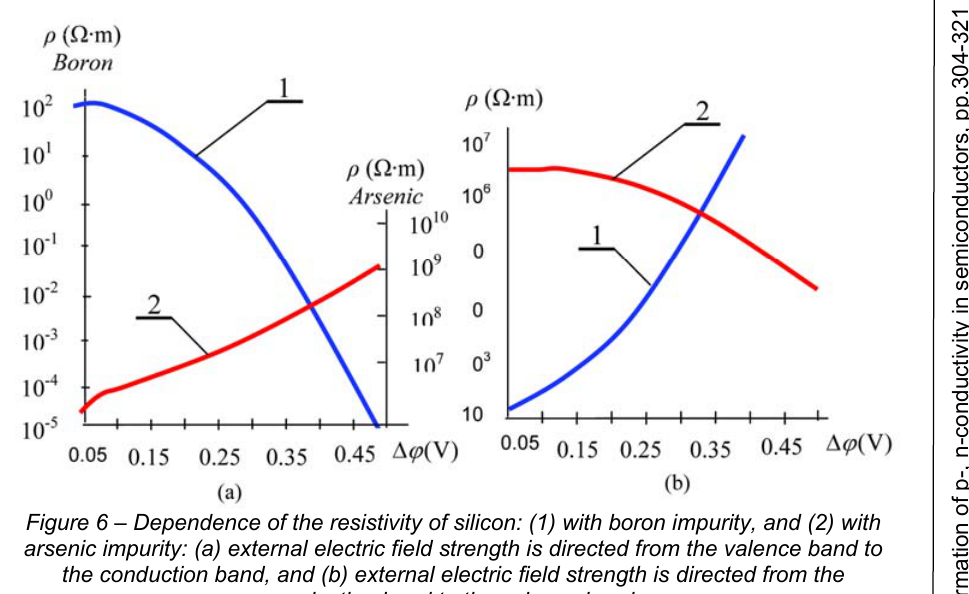
Figure 6 – Dependence of the resistivity of silicon: (1) with boron impurity, and (2) with arsenic impurity: (a) external electric field strength is directed from the valence band to the conduction band, and (b) external electric field strength is directed from the conduction band to the valence